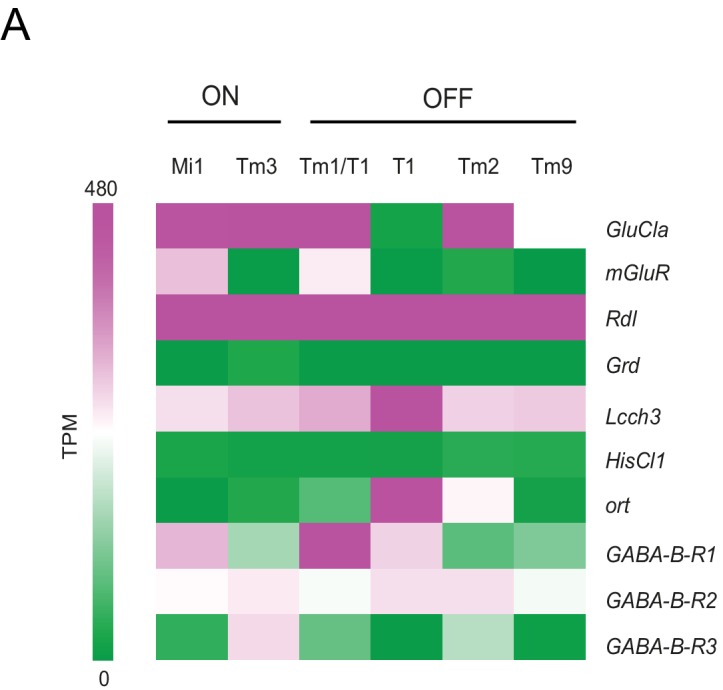
GluClα and Rdl are broadly expressed in the visual system.(A) Expression levels shown as TPM (transcripts per kilobase million) values of candidate glutamate, GABA and histamine receptors. RNAseq data are from Konstantinides et al. (2018) (GEO accession number: GSE103772). Expression in all available medulla interneurons in the data set of the major ON and OFF pathways components is depicted.